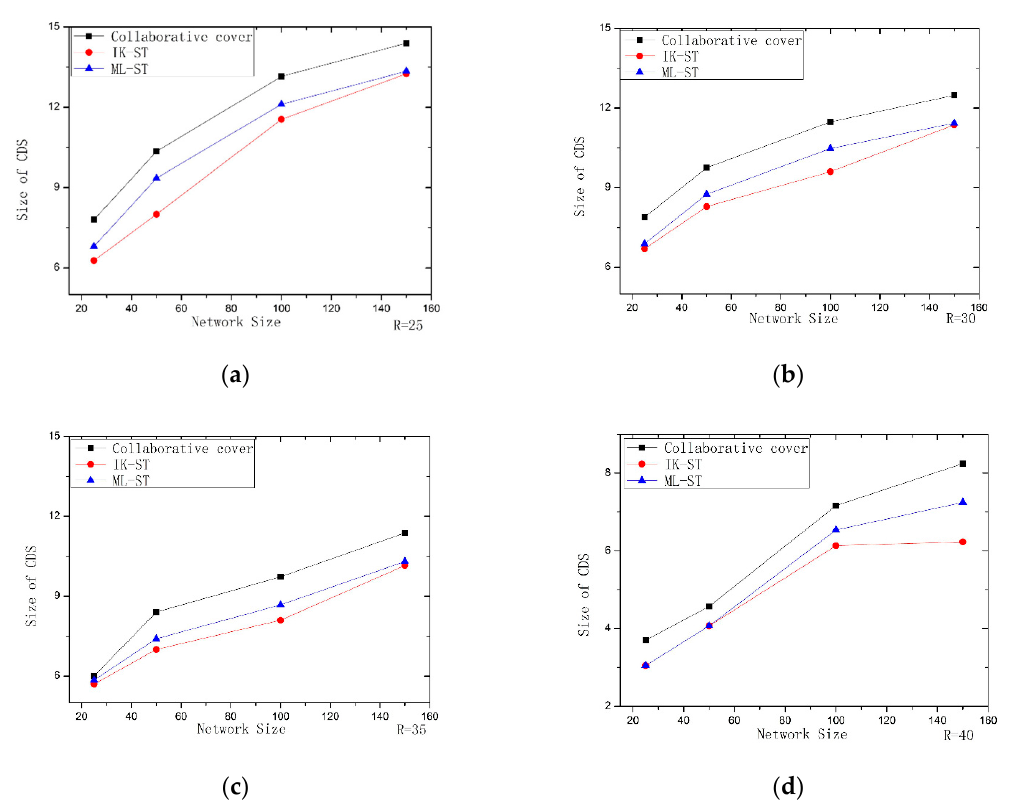
Figure 8. Performance comparison of IK–ST, ML-ST with Collaborative coverage: (a) R = 25; (b) R = 30; (c) R = 35; (d) R = 40.